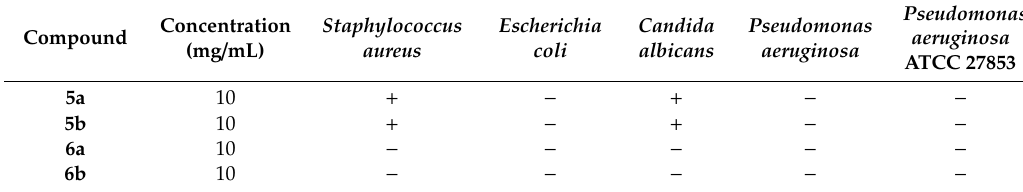
Table 3. Sensitivity of human pathogenic microbes at different concentrations of compounds 5a and 5b.